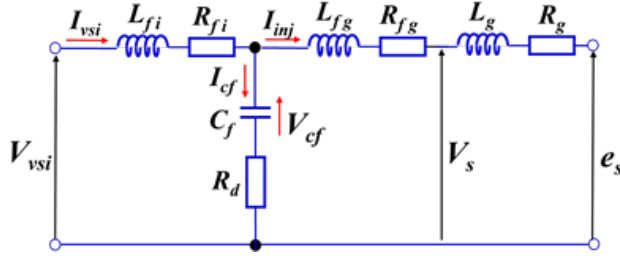
Figure 2. A single-phase circuit of the LCL output